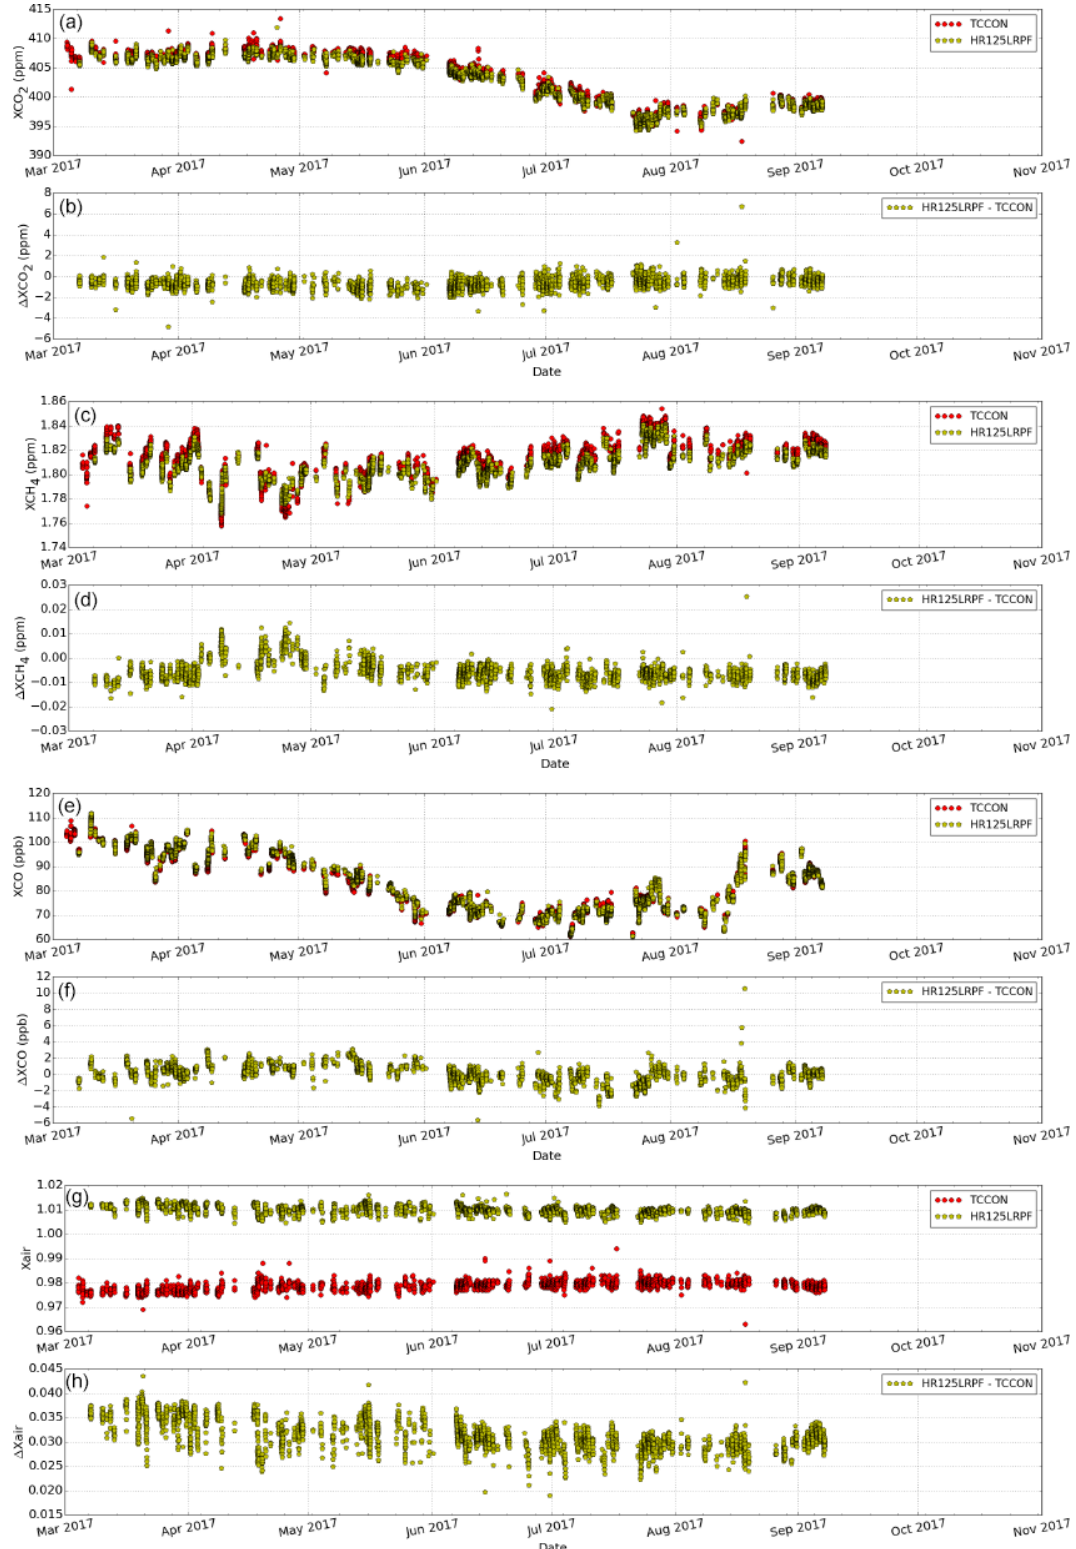
Figure C1. Time series of XCO 2 (a) , XCH 4 (c) , XCO (e) , and Xair (g) retrievals for TCCON and HR125LR using the standard procedure with the TCCON a priori for measurements performed at Sodankylä in 2017. The difference of XCO 2 (b) , XCH 4 (d) , XCO (f) , and Xair (h) time series for HR125LR relative to the reference TCCON